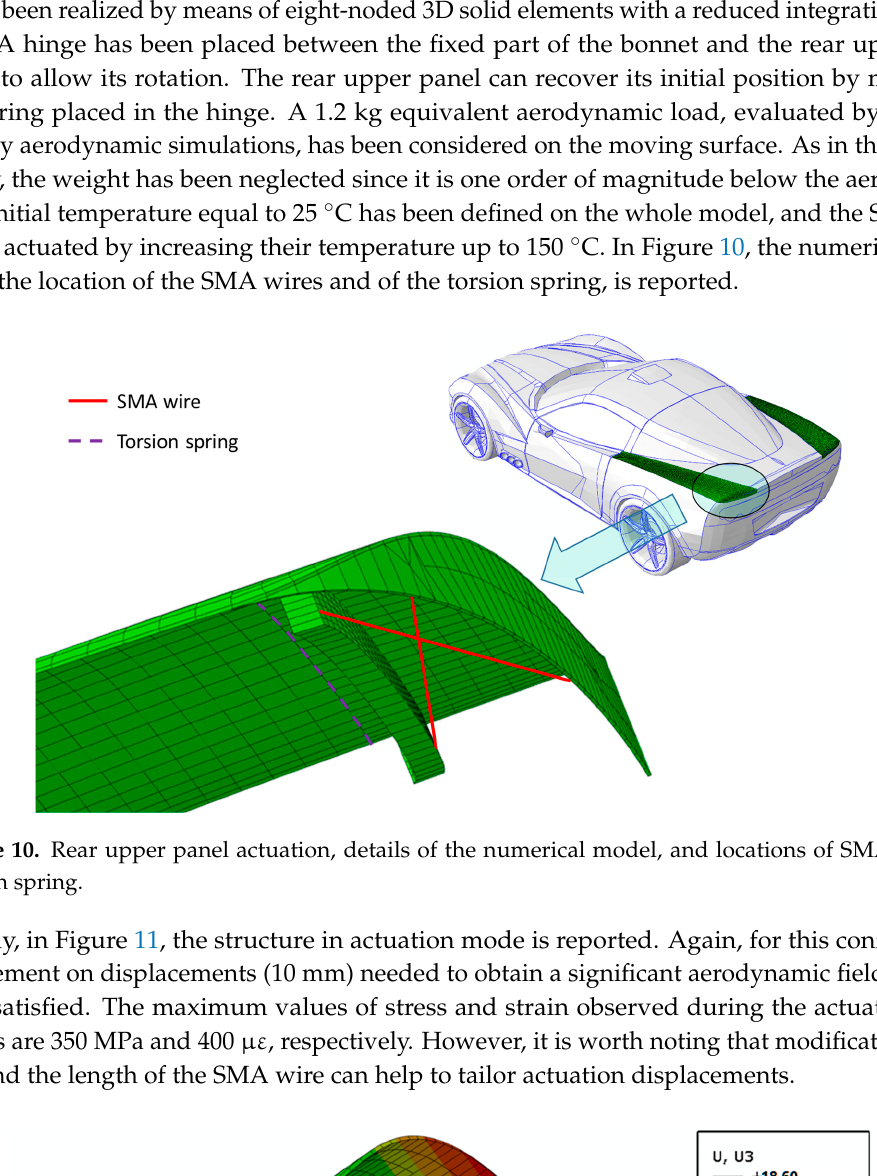
Figure 9. Case study #1: actuated structure. (unit: mm).